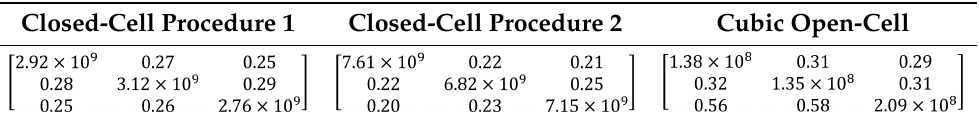
Table 4. Values of Young’s modulus (Pa) and Poisson’s ratio in all three directions for the closed-cell foam specimen with both procedures and for the cubic open-cell foam specimen.